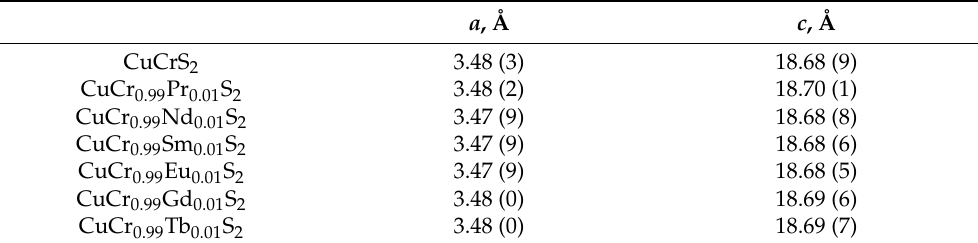
Figure 1. Powder diffraction patterns of the initial CuCrS 2 matrix and CuCr 0.99 Ln 0.01 S 2 (Ln = Pr, Nd, Sm, Eu, Gd, Tb) solid solutions. Table 1. Lattice parameters for the initial CuCrS 2 matrix and CuCr 0.99 Ln 0.01 S 2 (Ln = Pr, Nd, Sm, Eu, Gd, Tb) solid solutions.